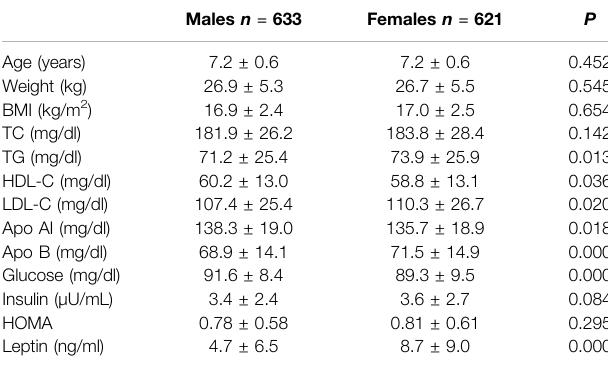
TABLE 1 | Anthropometric and biochemical characteristics (mean ± SD) of males and females.